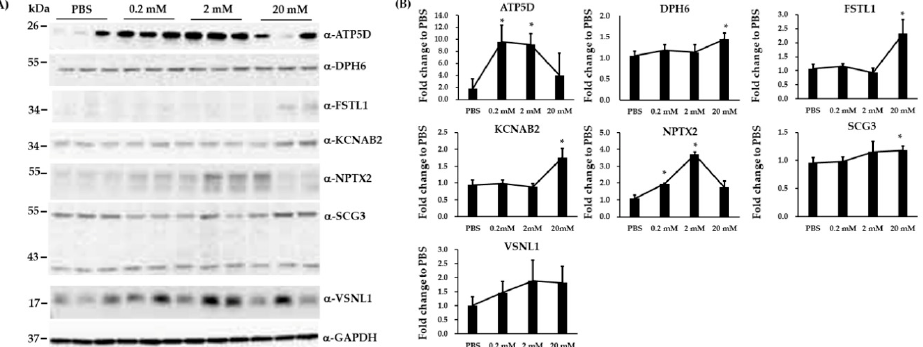
Figure 2. Immunoblotting analysis to validate the differential expression for 7 proteins in VPA-treated and PBS-treated biological replicated SH-SY5Y cells. ( A ) Immunoblotting showed the expression of ATP5D, DPH6, FSTL1, KCNAB2, NPTX2, SCG3, and VSNL1 in VPA-treated and PBS-treated SH-SY5Y cells. ( B ) Quantification showing the fold differences in the expression of ATP5D, DPH6, FSTL1, KCNAB2, NPTX2, SCG3, and VSNL1 between VPA-treated groups and PBS control. Glyceraldehyde 3-phosphate dehydrogenase (GAPDH) was a loading control. Data are expressed as fold change to PBS ± SD (* p < 0.05, n =